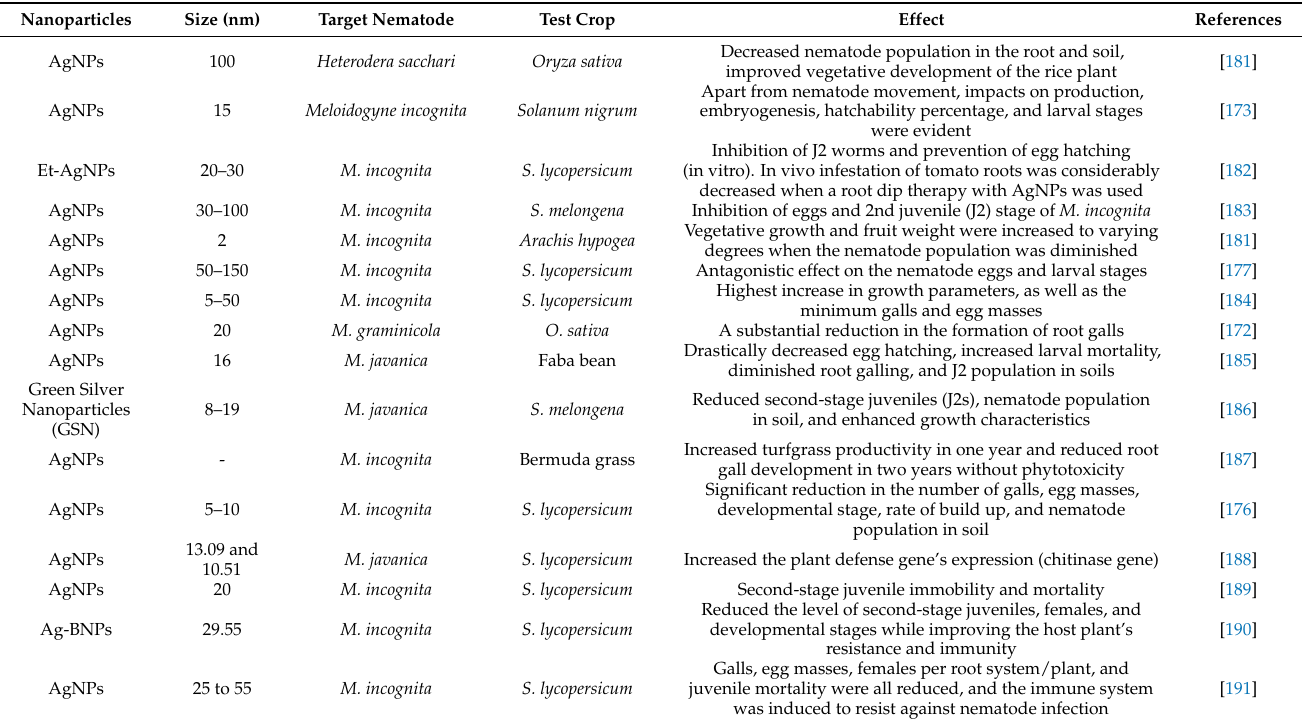
Table 7. AgNPs in nematode disease